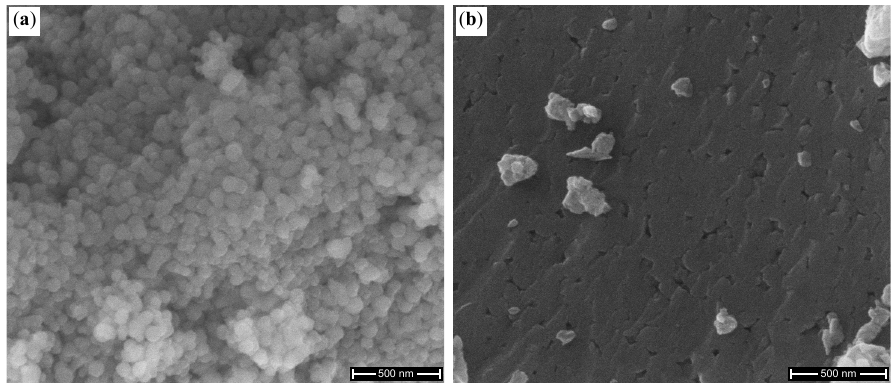
Figure 16. SEM images showing two distinct zones for G34475 (opal-A from Dubnik, Slovakia): ( a ) dull opaque zone and ( b ) white translucent zone.